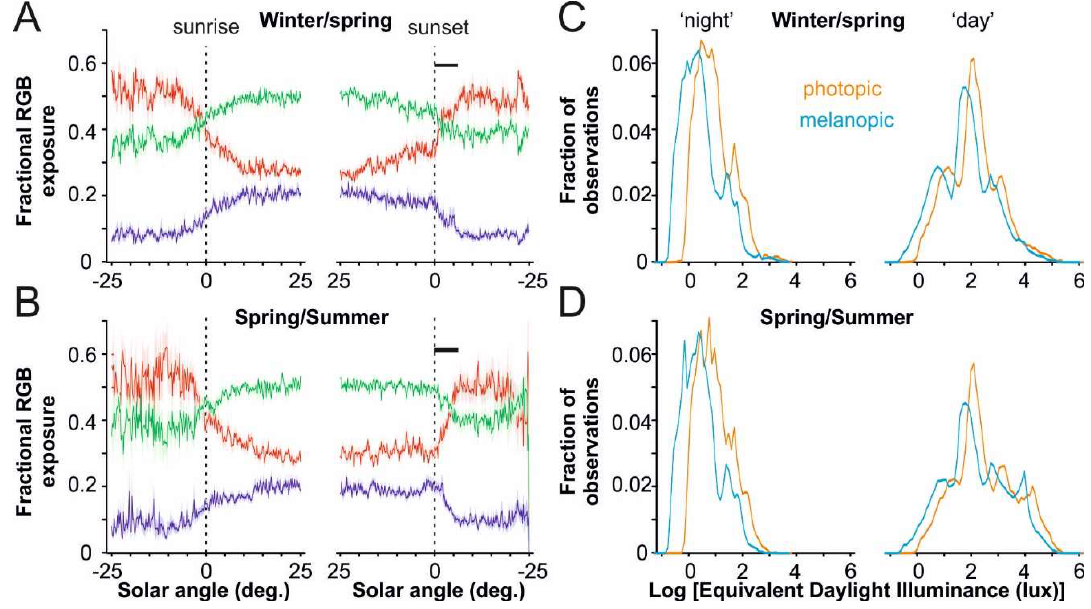
Figure 3. Daily di ff erences in light quality experienced by the Old Order Amish. ( A , B ) Mean ± SEM fractional exposure to long (red), medium (green) and short-wavelength light (blue) around dawn and dusk in 33 OOA subjects during winter / spring ( A ) and spring / summer ( B ) months. Photoperiod-related di ff erences were observed only around dusk (actual-civil sunset; indicated by black line). ( C , D ) Proportional distribution of apparent melanopic and photopic Equivalent Daylight Illuminance experienced by the 33 OOA subjects outside of daylight hours (‘night’; left) and during the day (right) during winter / spring ( C ) and spring / summer ( D ) months.